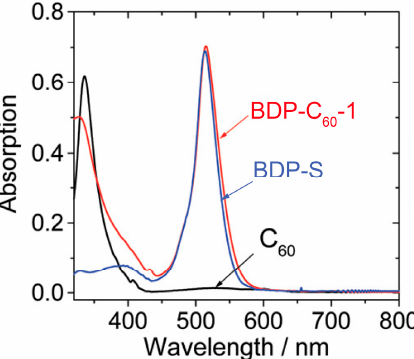
Figure 14. UV − vis absorption spectra of BDP-C 60 -1 and the antennas of the dyads BDP-S. c = 1.0 × 10 − 5 M in toluene, 20 °C. Reproduced with permission from reference [78], copyright 2012, American c = 1.0 × 10 − 5 M in toluene, 20 ◦ C. Reproduced with permission from reference [78], copyright Chemical Society. 2012, American Chemical